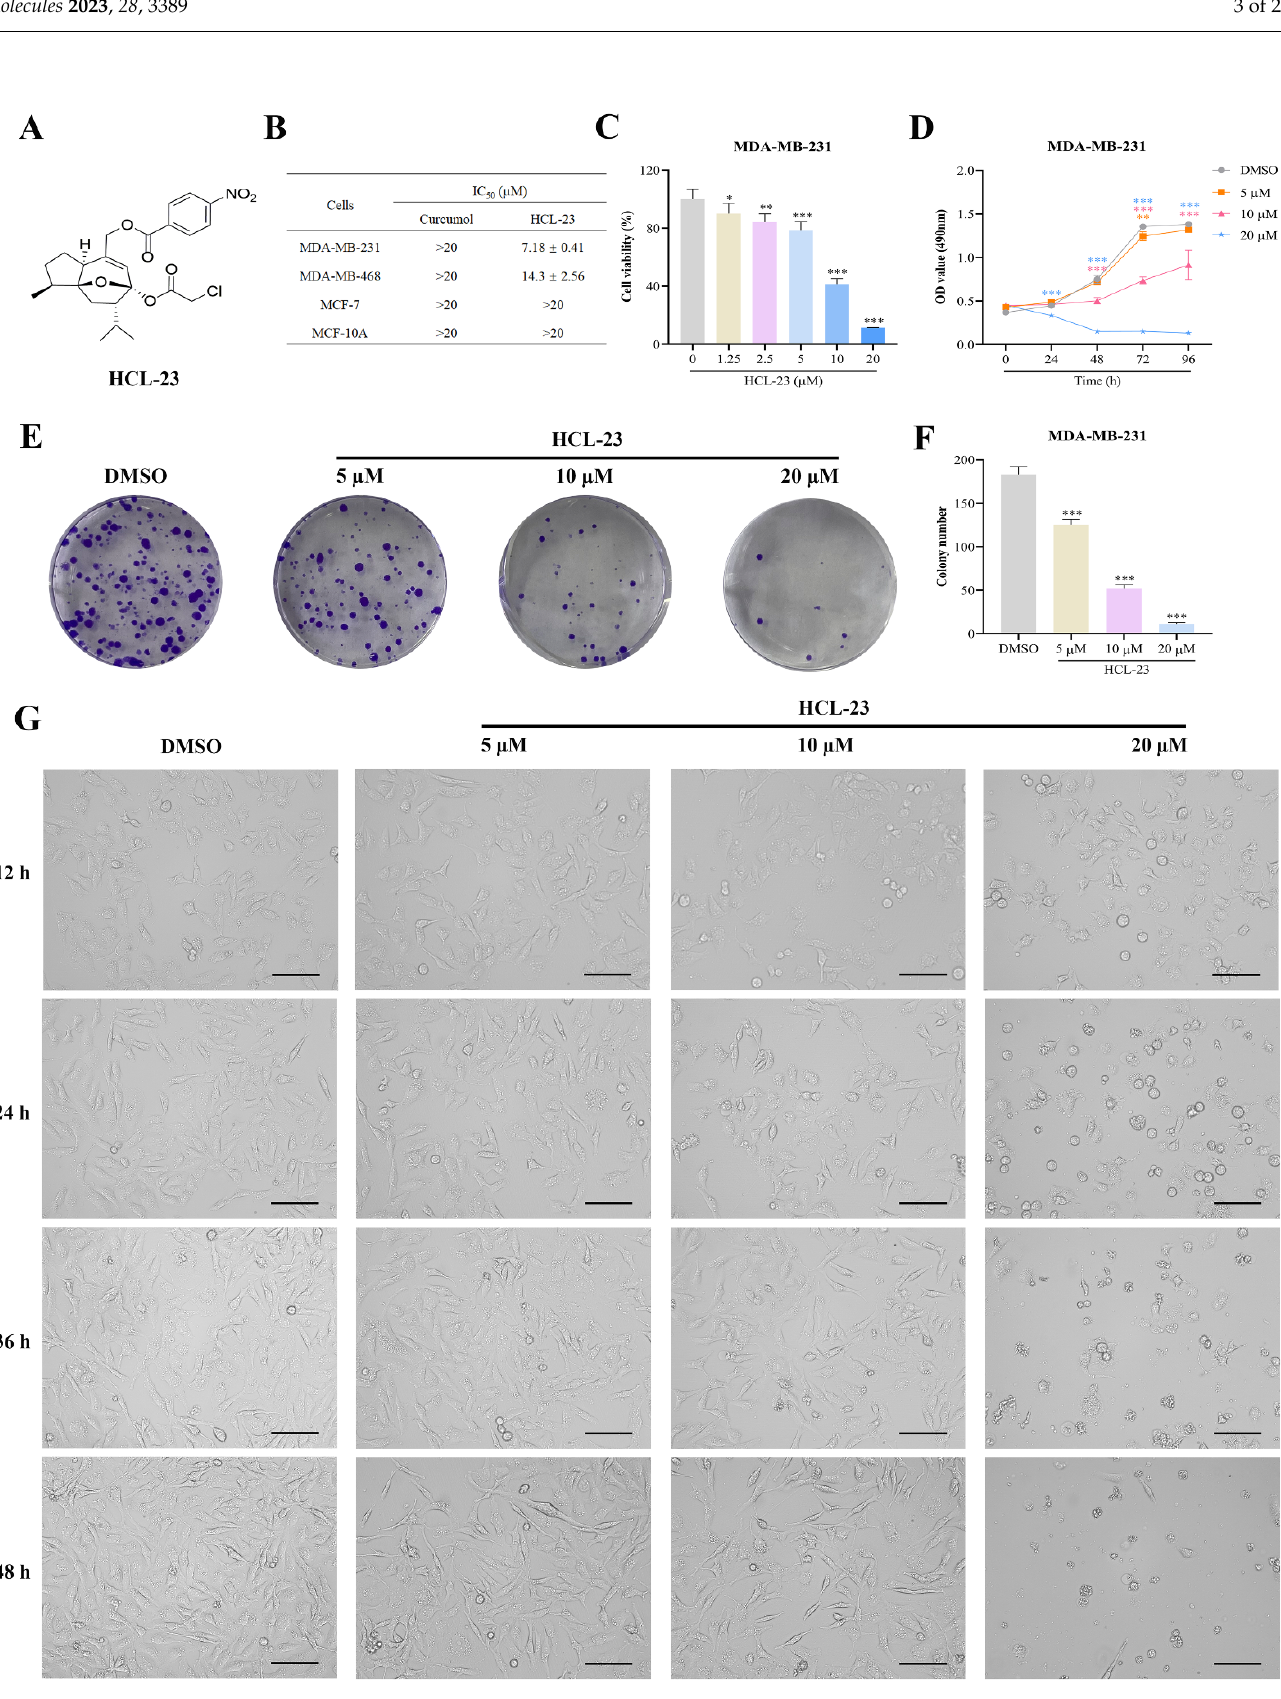
Figure 1. HCL-23 inhibits cell proliferation in MDA-MB-231 cells ( A ) Chemical structure of HCL-23. ( B ) The IC 50 values of HCL-23 in the human breast cancer cell lines MDA-MB-231, MDA-MB-468 and MCF-7 and the human normal mammary epithelial cell line MCF-10A at 72 h. ( C ) MDA-MB- 231 cells were treated with different concentrations of HCL-23 (1.25, 2.5, 5, 10, and 20 µM) for 72 h. The cell viability was measured using an MTT assay. ( D ) The effect of HCL-23 on MDA-MB-231